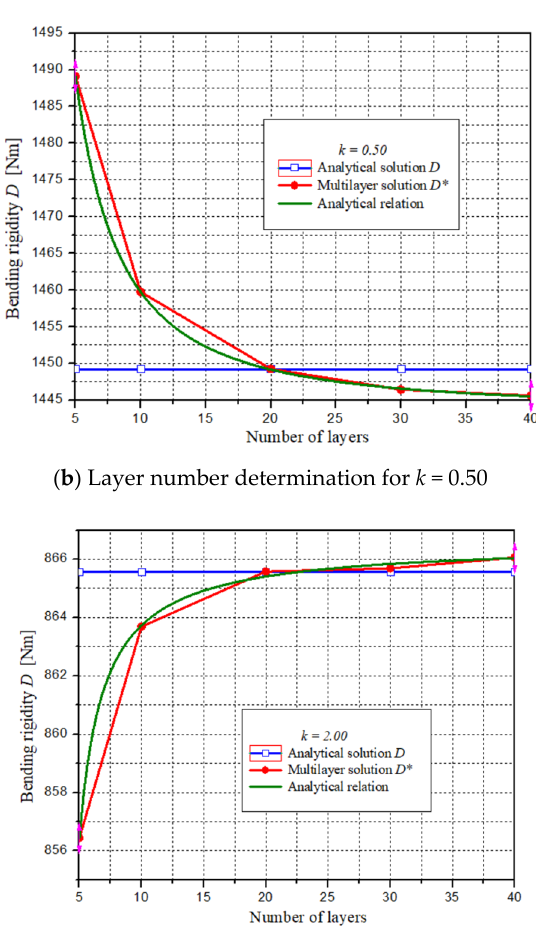
Figure 9. Bending rigidity curves and their errors versus power coefficient k.